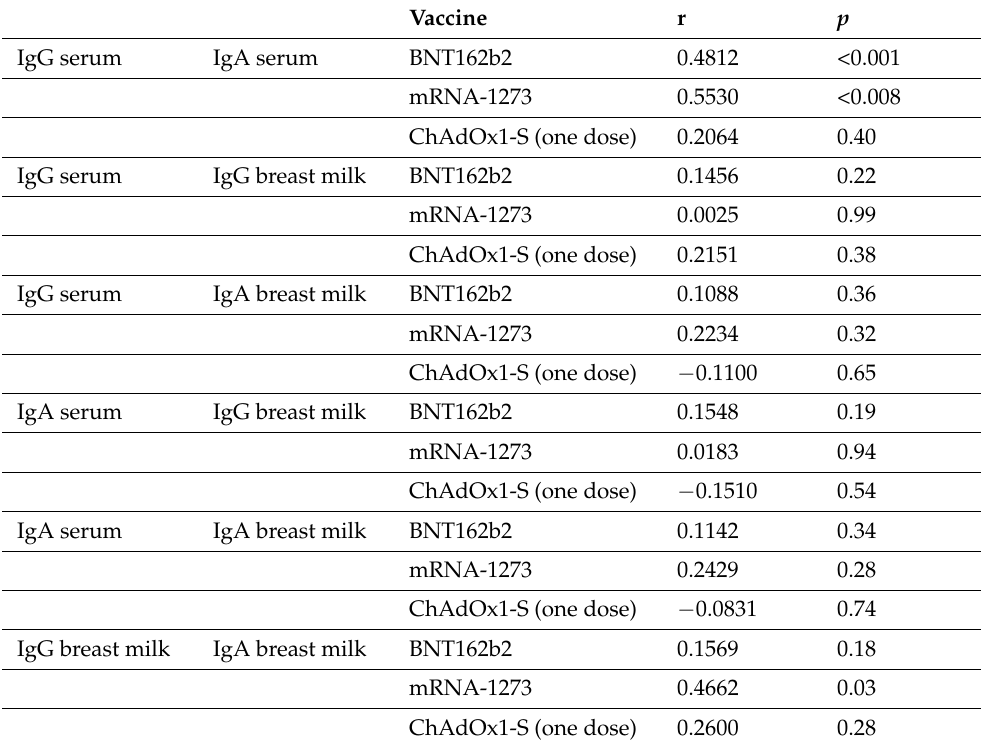
Table 5. Linear correlation coefficients between levels of IgG and IgA in serum and breast milk according to the type of vaccine received.